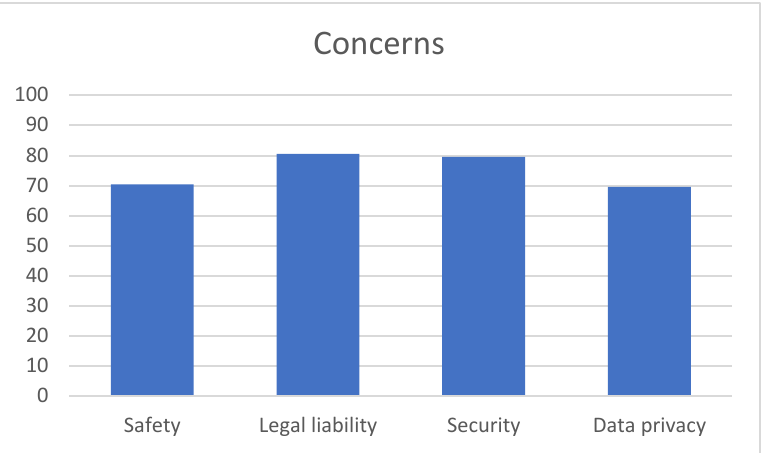
Figure 2. Concerns about AVs in South Korea.